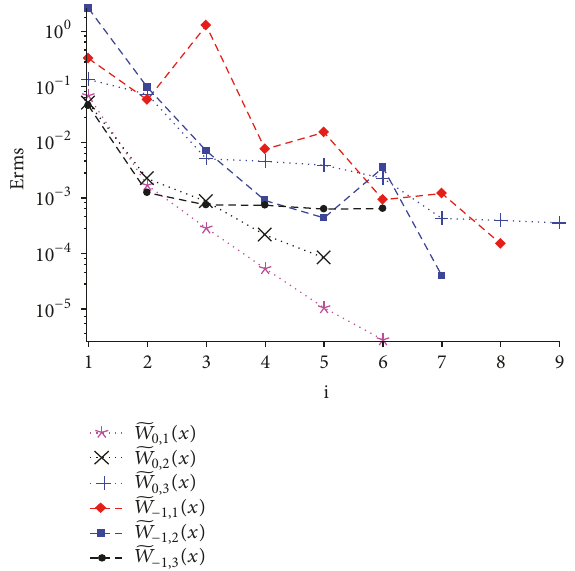
Figure 8: 𝐸 rms for the different 𝑖 trial functions for